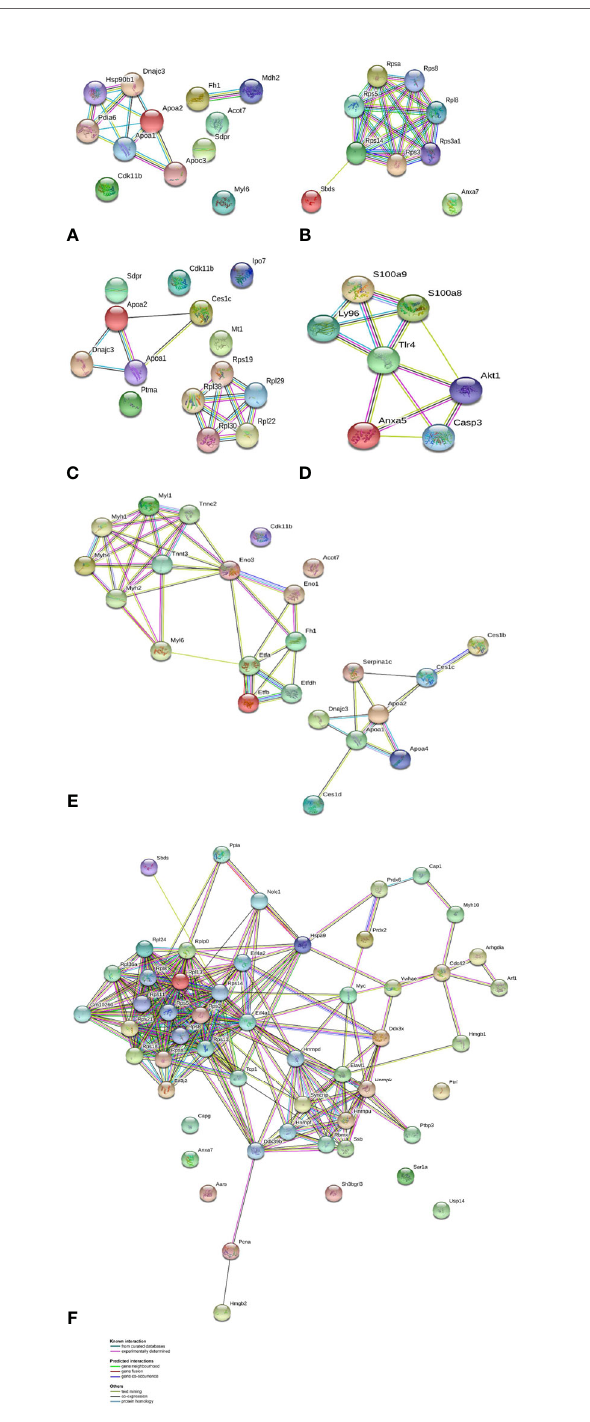
FIGURE 4 | Protein-protein interaction networks identi fi ed using STRING for differential proteins in abundance. Different line colors represent the types of evidence for association. Gene names are shown. (A) AG.1 group up- accumulated proteins, (B) AG.1 group down-accumulated proteins, (C) 5-FU group up-accumulated proteins, (D) 5-FU group down-accumulated proteins, (E) combinatorial group (AG.1 with 5-FU) up-accumulated proteins, and (F) combinatorial group (AG.1 with 5-FU) down-accumulated